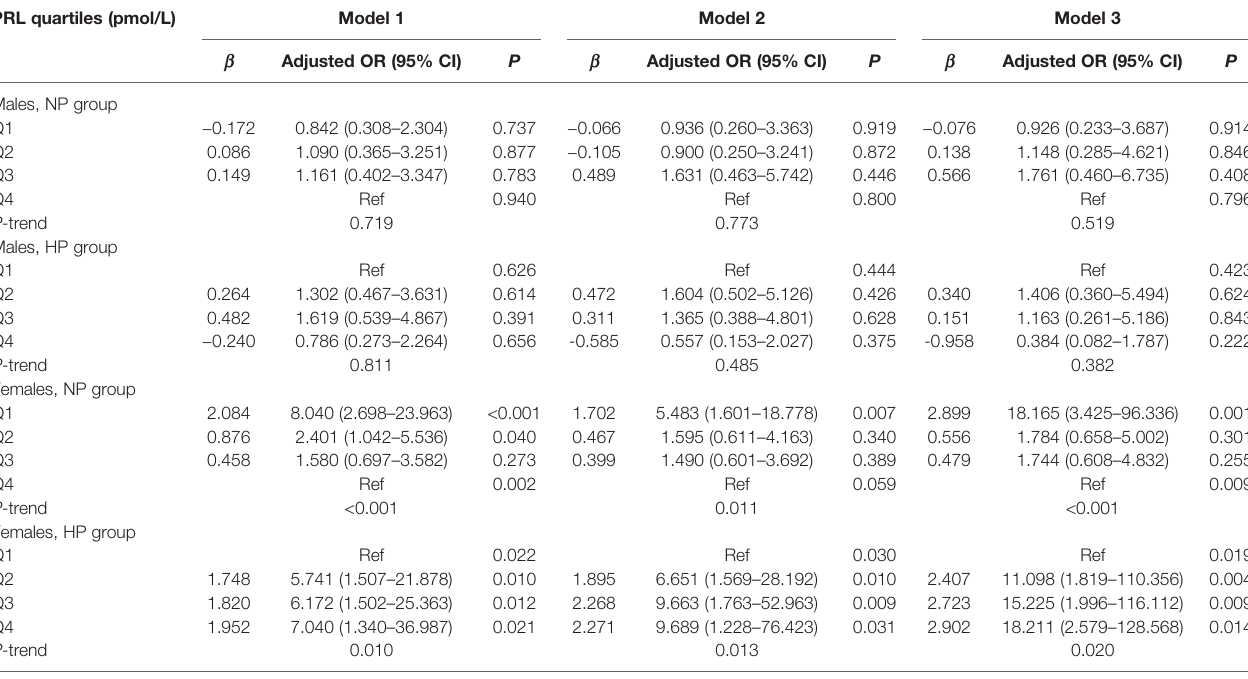
TABLE 3 | Multiple-adjusted odds ratios (AORs) and 95% con fi dence intervals (95% CI) for MAFLD, according to serum PRL quartiles: results of binary logistic regression analysis in different models. PRL quartiles (pmol/L)